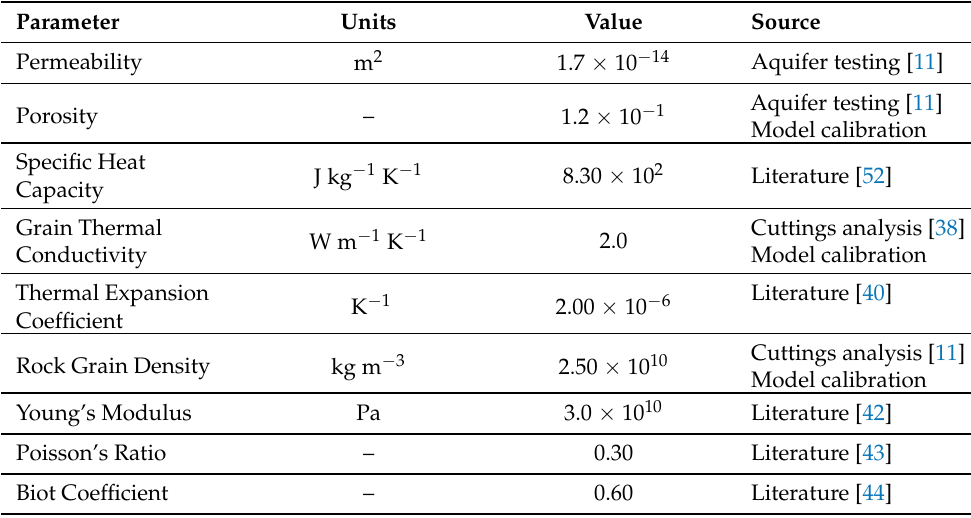
Table 3. Properties for the sedimentary overburden used in the native state simulation. Values based on field and laboratory measurements and model